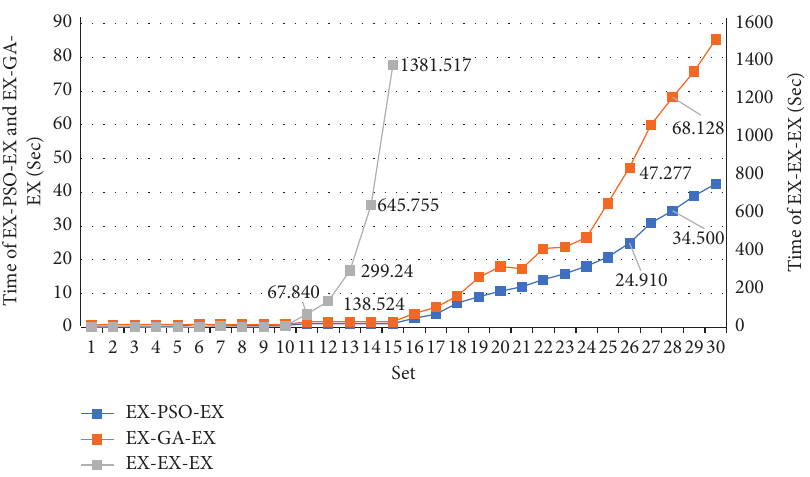
Figure 7: Comparison of CPU time in EX-EX-EX, EX-PSO-EX, and EX-GA-EX (sets 1–30).